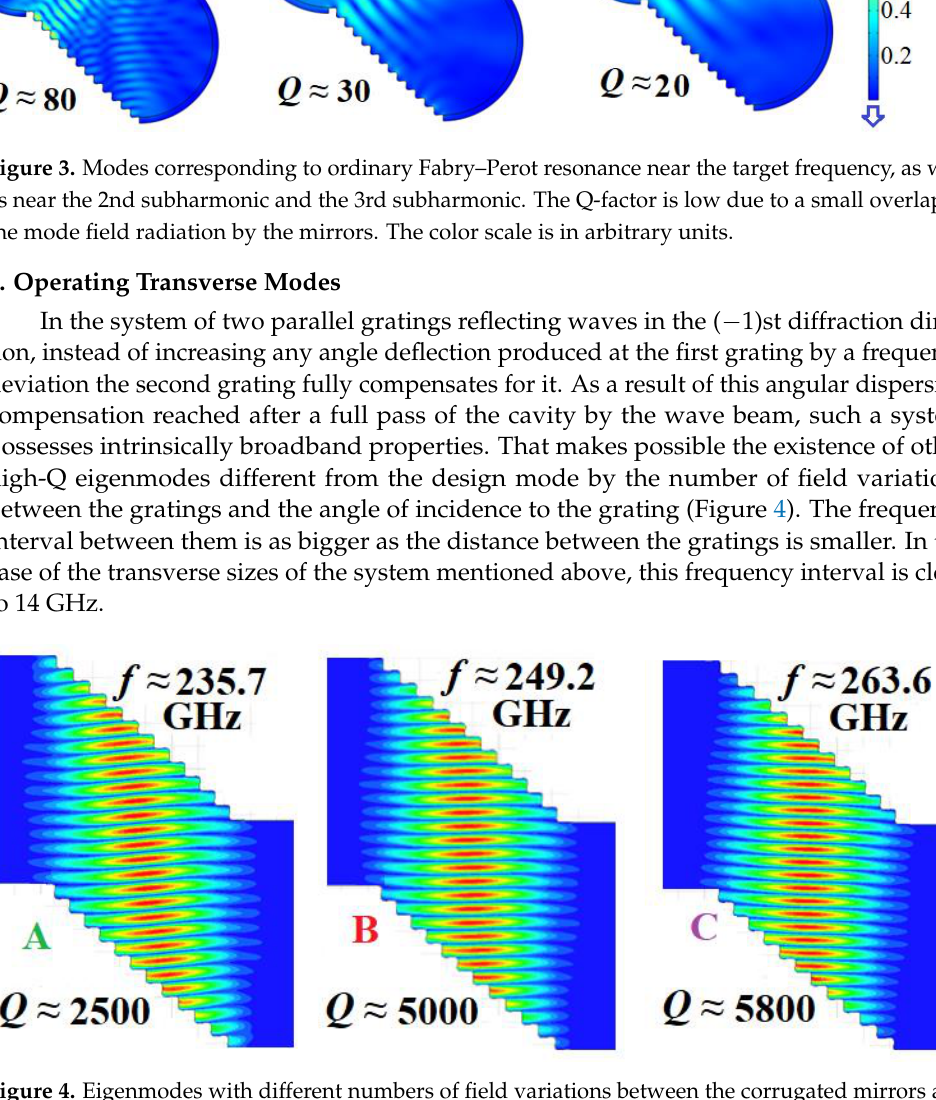
Figure 4. Eigenmodes with different numbers of field variations between the corrugated mirrors and their Q-factors in the case of the distance between the corrugated mirrors h = h 0 = 10 mm. The modes A, B, and C are described by curves A, B, and C in Figure 5.